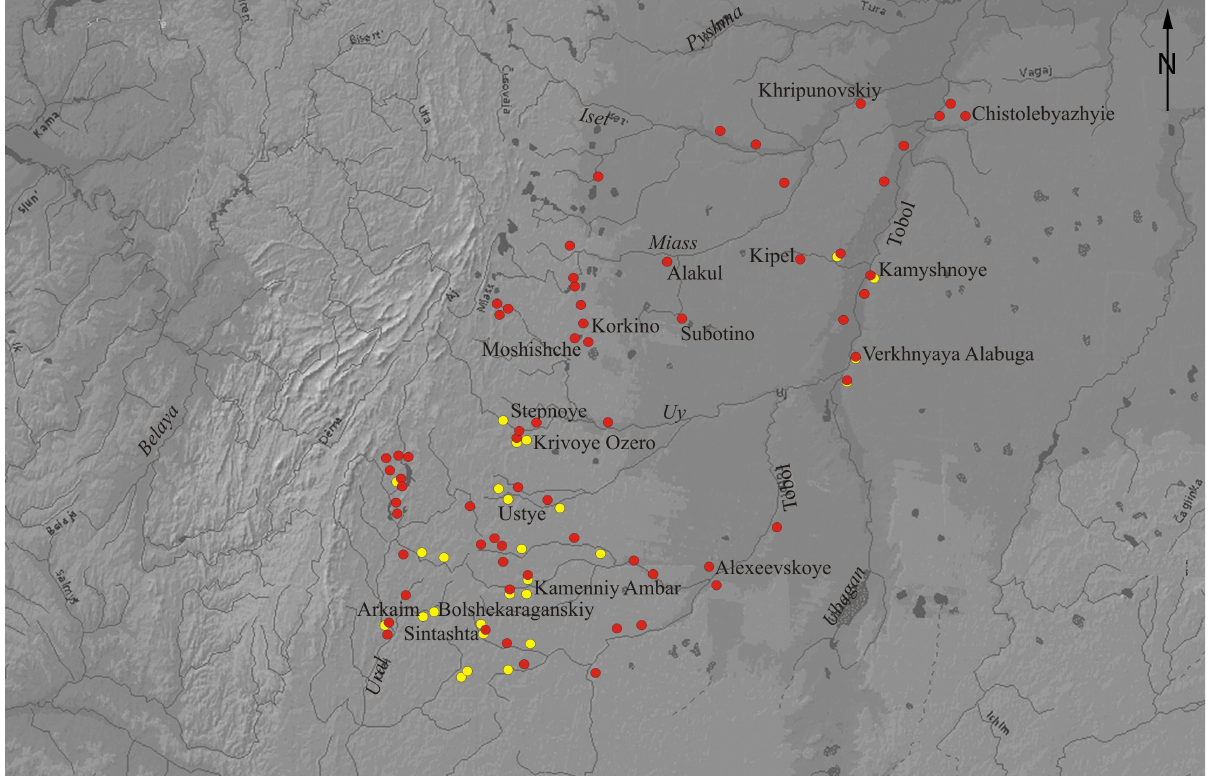
Figure 17: Map of the distribution of Sintashta (yellow circles) and Alakul (red circles) sites in the Transurals. The border between the steppe and forest-steppe is along the Uy River (after Grigoriev,